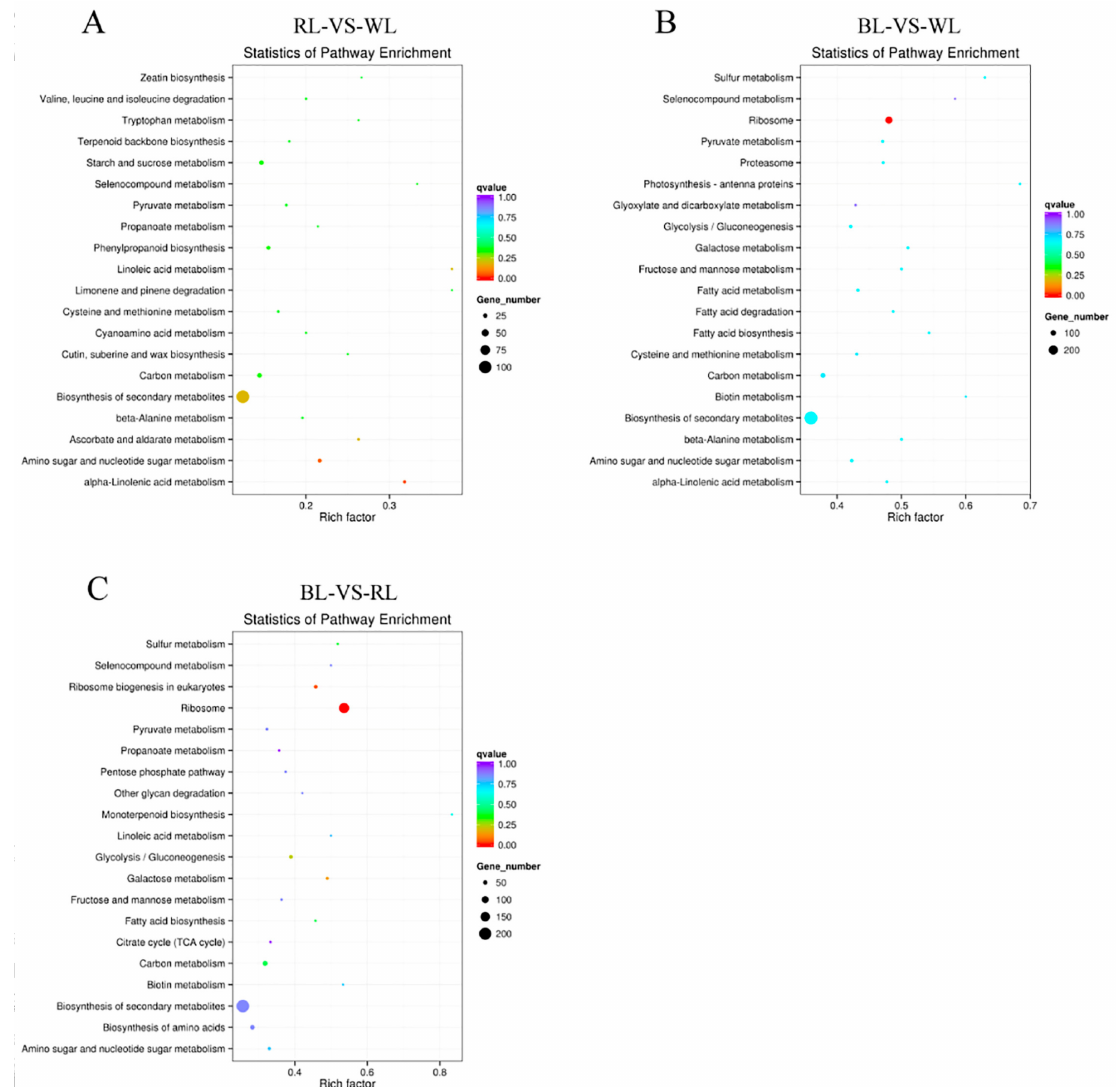
Figure 3. Top 20 enriched KEGG pathways among the annotated DEGs in three pairwise comparisons. ( A ) RL-VS-WL; ( B ) BL-VS-WL; and ( C ) BL-VS-RL. The Y-axis on the left represents KEGG pathways, and the X-axis indicates the enrichment factor. Low q-values are shown in red, and high q-values are depicted in blue. Pathways with q-values less than 0.05 are significantly enriched. The size of the spot reflects the number of DEGs, and the color of the spot corresponds to different q-value ranges. WL, RL, and BL indicates samples treated by white light, red light, and blue light,